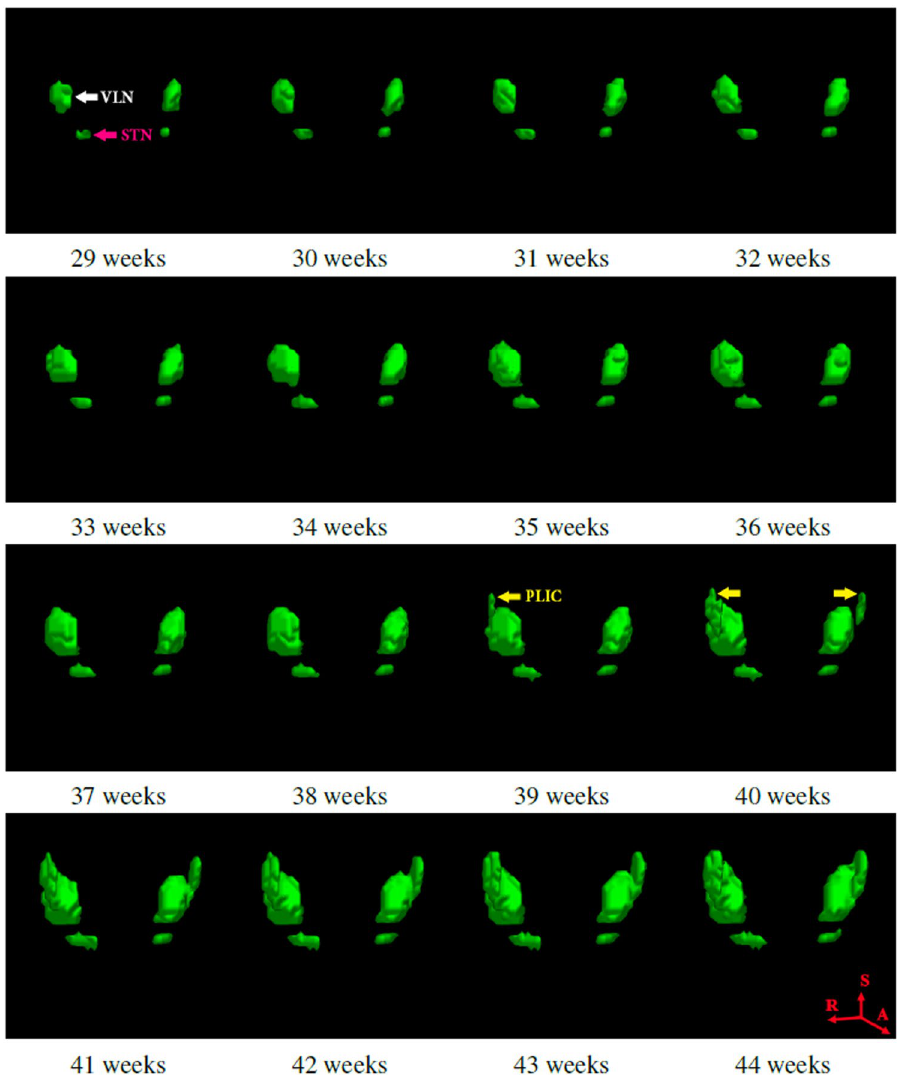
Figure 2. Spatio-temporal growth model for myelin-like signals (MLS) in the deep brain region between 29 and 44 weeks GA. The ventrolateral nuclei (VLN) and subthalamic nuclei (STN) appear to be myelinated before 29 weeks GA. MLS becomes evident in both tracts of the posterior limbs of the internal capsule (PLIC) at approximately 40 weeks GA. This is an important landmark for evaluating neonatal brain development. As the different deep brain region sizes in individual subjects have been corrected through non-rigid registration, the progression of MLS is completely due to the appearance of new myelination without contribution from the overall brain